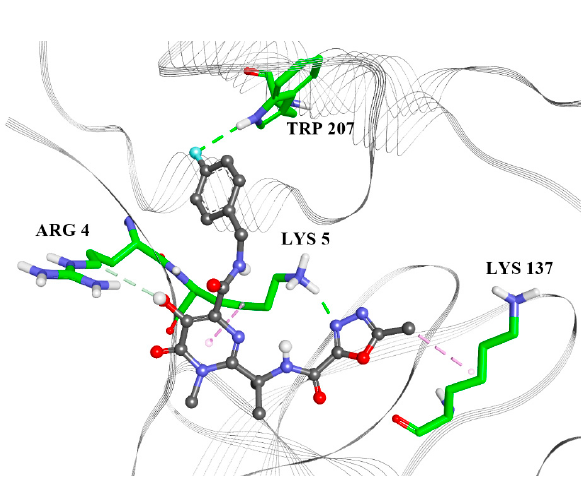
Figure 5. Raltegravir in the M pro allosteric site. Green lines — hydrogen bonds; purple — alkyl – π /hydrophobic interactions; white line — carbon hydrogen bond. Table 4. Protein – ligand interactions in the allosteric domain.